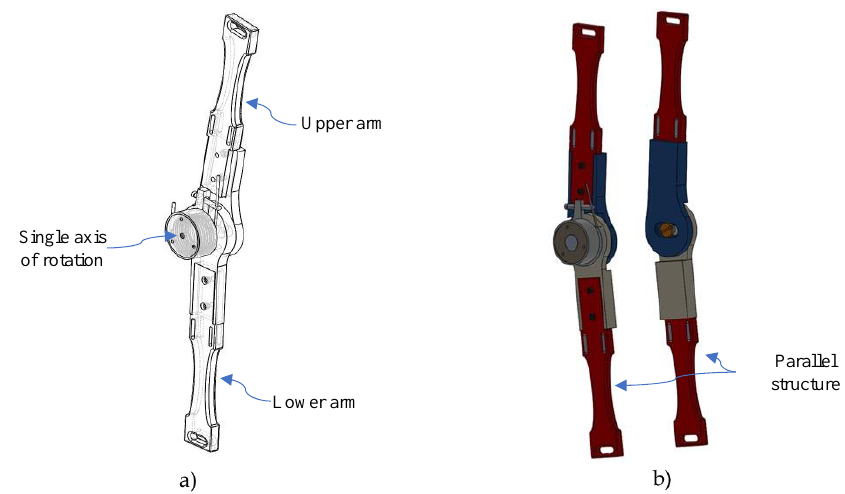
Figure 12. Basic governed structure of attached exoskeleton: ( a ) one-sided; ( b ) two-sided.